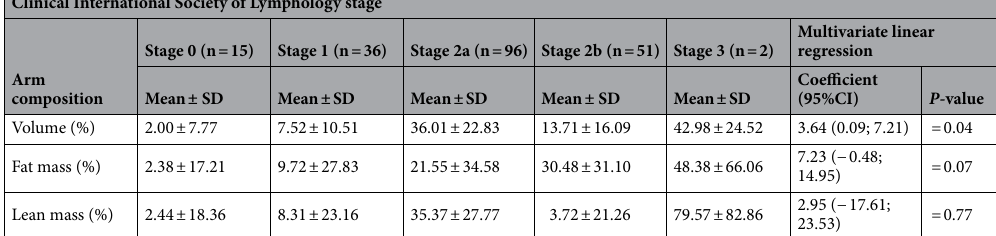
Table 2. Clinical lymphedema stage and excess volume, fat mass, and lean mass. This table shows the association between clinical lymphedema stage and excess volume, fat mass, and lean mass. The multivariate regression model was adjusted for age, BMI, arm dominance, lymphedema duration, and lymphedema latency. N = number of patients at each stage. SD standard deviation.